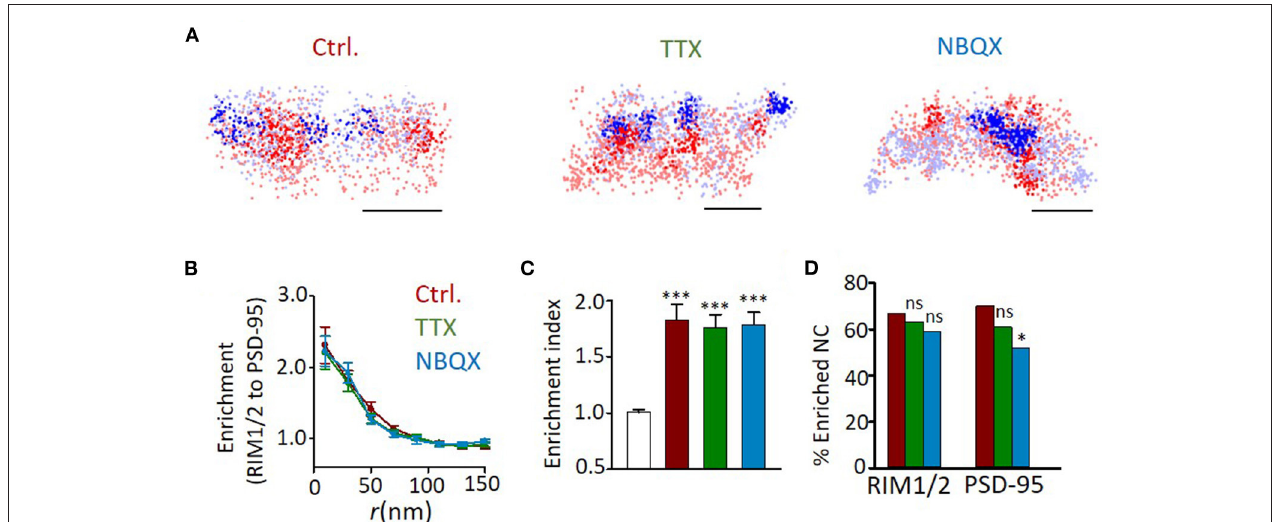
FIGURE 6 | Effects of activity blockade on development of trans-synaptic nano-alignment. (A) Example distribution maps of both RIM1/2 (blue) and PSD-95 (red) with nanoclusters highlighted with thick color. Scale bars, 200nm. (B) Normalized local density of RIM1/2 along with distances from PSD-95 nanoclusters for synapses from DIV18 cultures with different activities. (C) Averaged enrichment of RIM1/2 within 50nm from peaks of PSD-95 nanoclusters ( n = 60, 40, 51, and 49 nanoclusters). The open bar represents the enrichment indices of synapses with the position of nanoclusters randomized within synaptic clusters. (D) Fraction of nanoclusters that were enriched with protein across the cleft. * p < 0.05, *** p < 0.001, one-way ANOVA with Tukey’s multiple comparisons in (C) , z -test in (D) . Also refer to Supplementary Table 1 for more statistical details. All experiments were repeated ≥ 3 times.